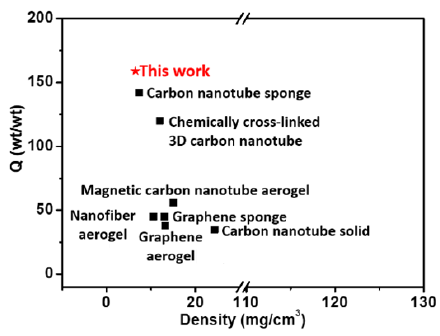
Figure 6. The comparison of kerosene sorption capacities of SWNT aerogels and previously reported sorbents. Carbon nanotube sponge [20]; Chemically cross-linked 3D carbon nanotube [37]; Magnetic carbon nanotube aerogel [21]; Nanofiber aerogel [36]; Graphene sponge [38]; Graphene aerogel [39]; Carbon nanotube solid [40].